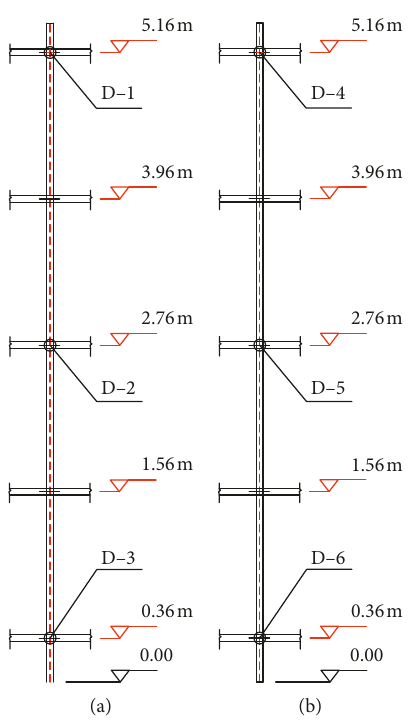
Figure 9: Layout of strain gauges on vertical rods of Models 4 and